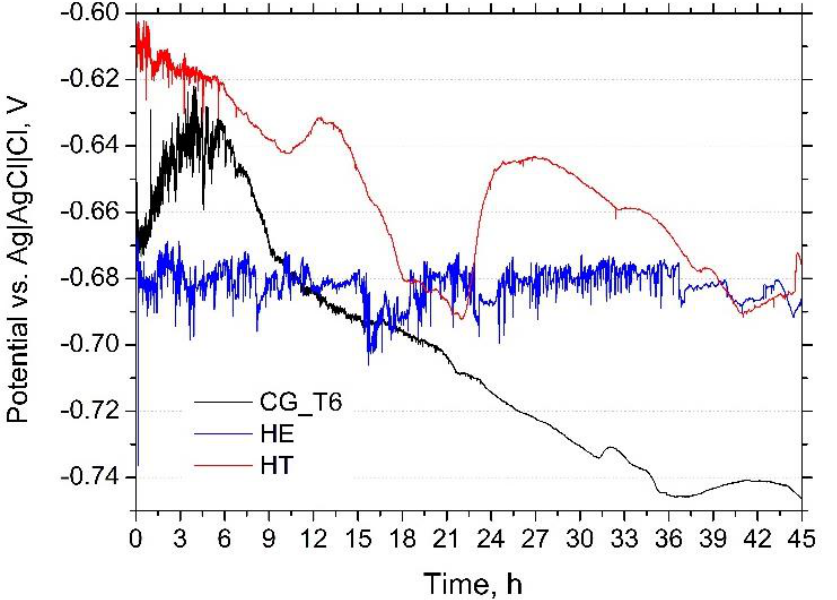
Figure 3. E OCP vs. time recorded during 45 h immersion of CG_T6, HE and HT 7475 Al alloy in 0.1 M NaCl.